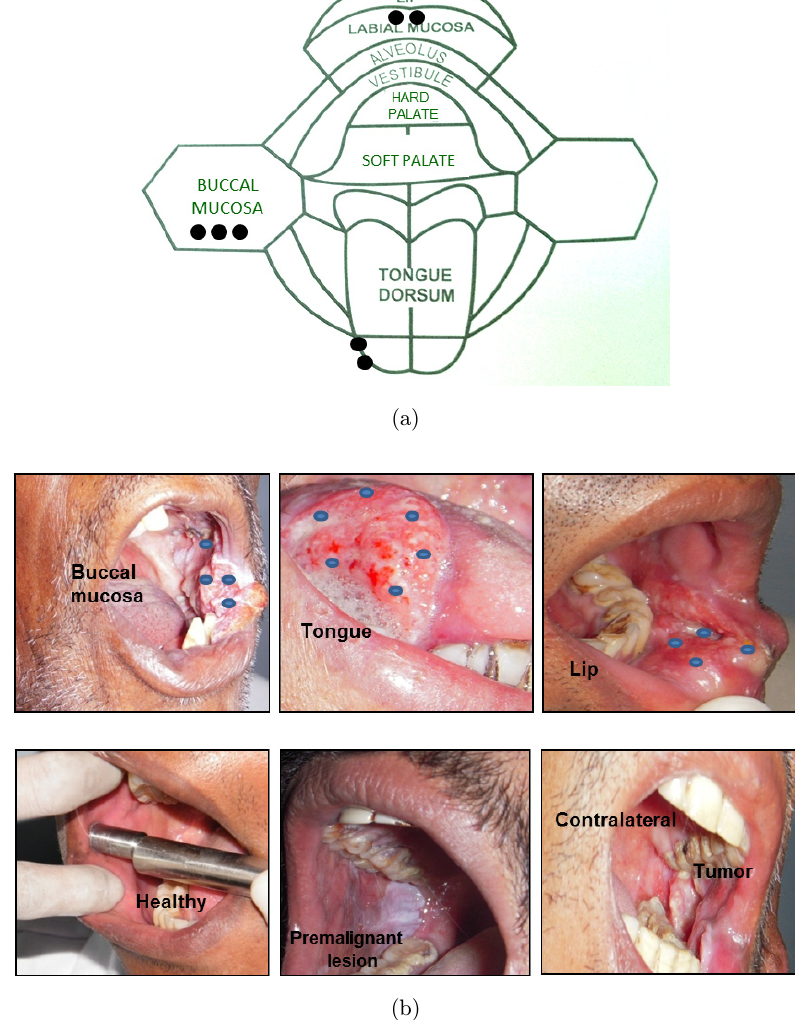
Fig. 1. (a) Schematic representation of spectra acquisition sites at buccal mucosa, lip and tongue in healthy and contralateral subsites, (b) Photographical representation of spectral acquisition scheme for spectral acquisition from tumors on buccal mucosa, tongue and lip in the ¯rst panel and spectral acquisition scheme from healthy, premalignant, contralateral and tumor sites for a particular subsite (buccal mucosa) in the second